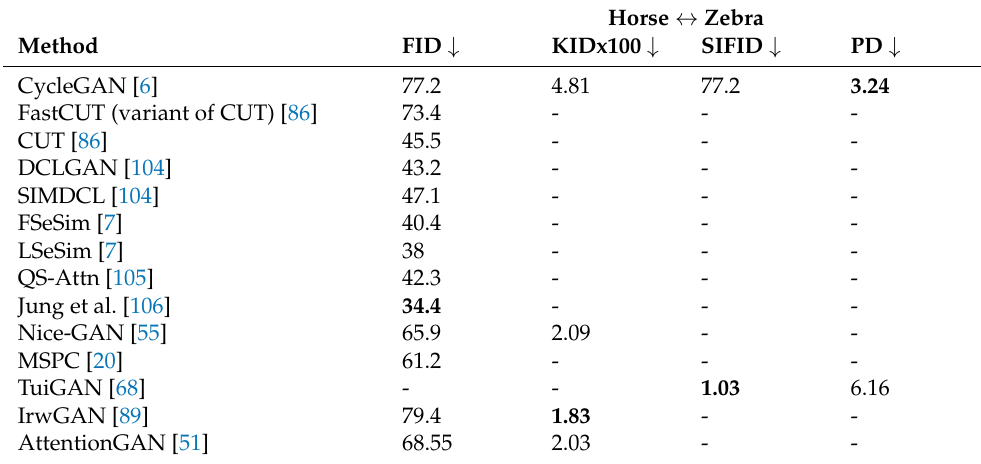
Figure 7. Dataset usage of papers in this review. ( a ) The use of datasets in the papers of this review; ( b ) the metric usage of the reviewed papers. Table 1. Aggregation of reviewed paper results on the “horse ↔ zebra” dataset. Results taken from papers. Numbers in bold are the results of the best performing models in a given metric. “-” indicates that no results have been found. Results taken from